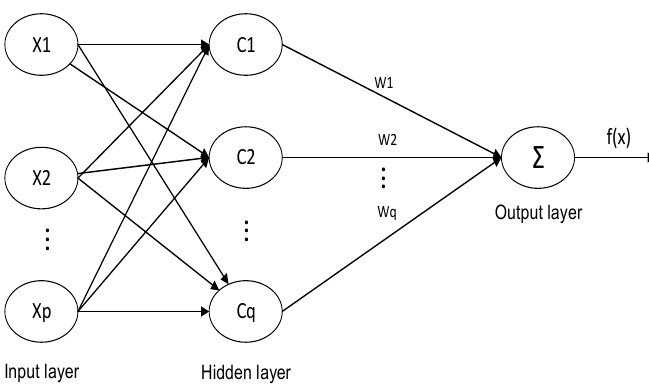
Figure 7. Separated error and white noise.